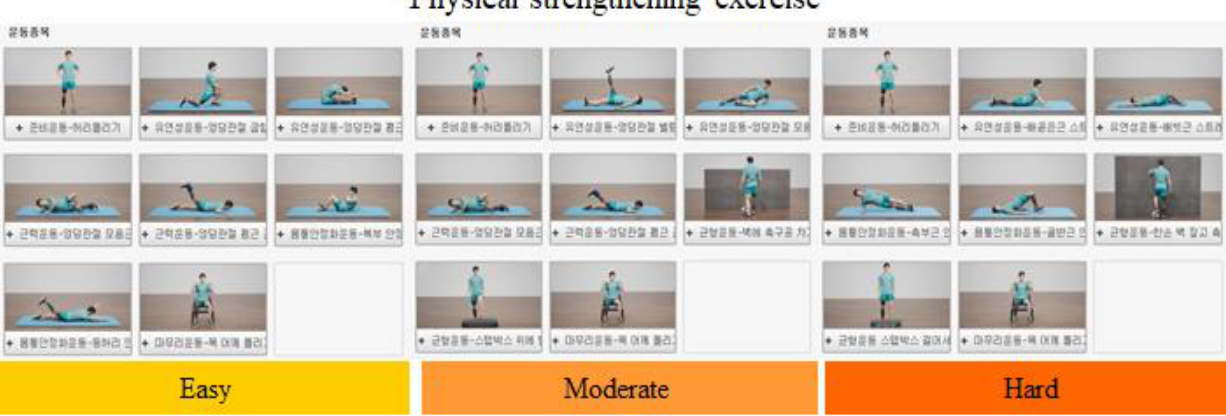
Figure 2. Three-dimensional animated exercise video content for lower-extremity amputees, includ-